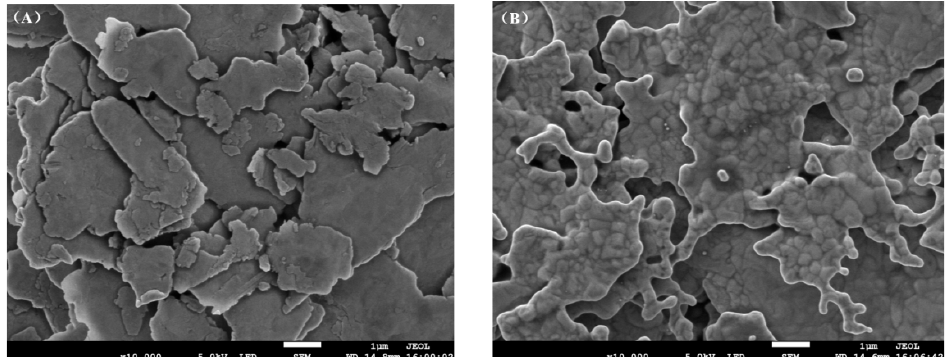
Figure 6. Microstructure of the heterojunction (HJT) silver paste with the curing agent dosage of 41 wt%: ( A ) before curing; ( B ) after curing at 199 °C for 44 min.